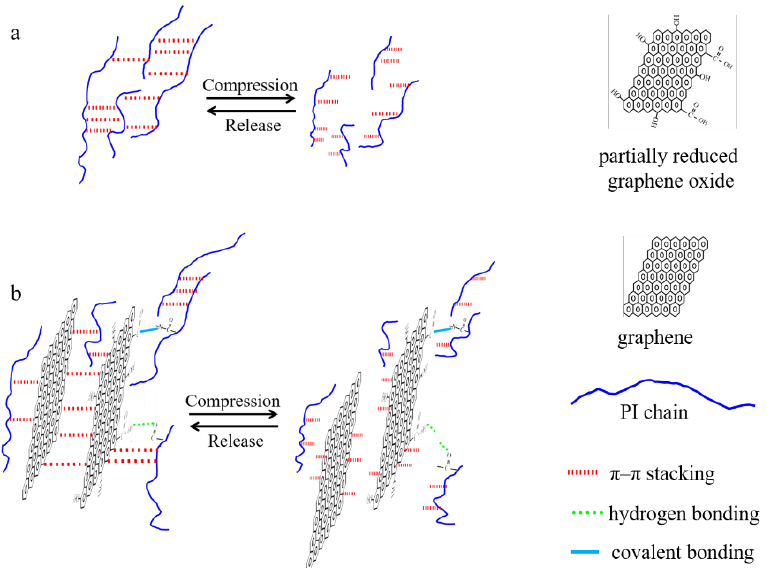
Figure 3. Schematic of strengthening and toughening mechanism of pure PI aerogel ( a ) and hybrid aerogels ( b ).